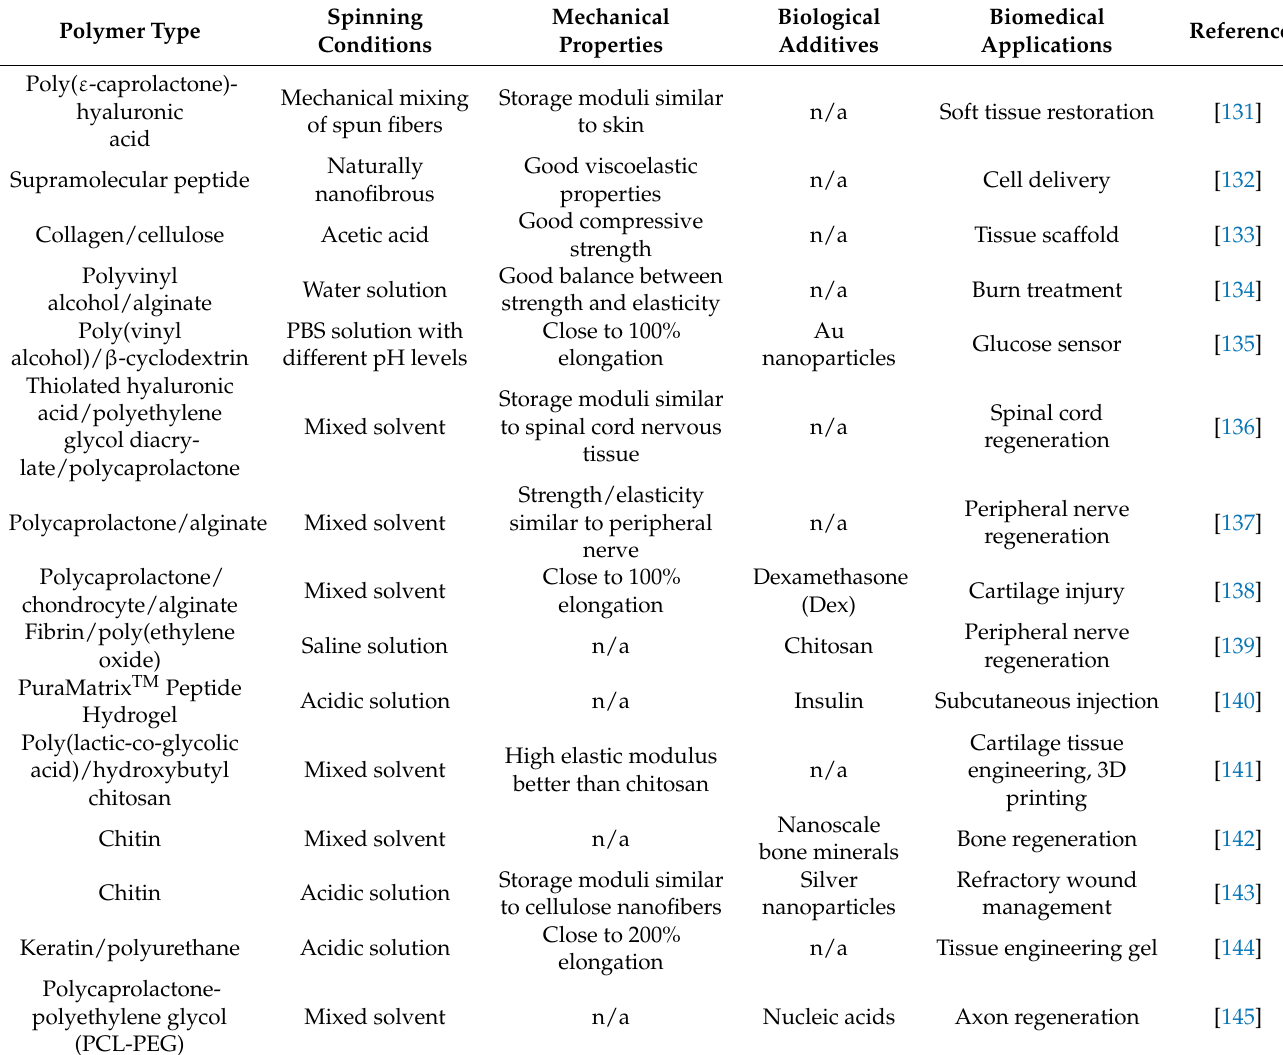
Table 2. A summary of nanofibers in hydrogels, including types of polymers or polymer blends used and the resultant mechanical